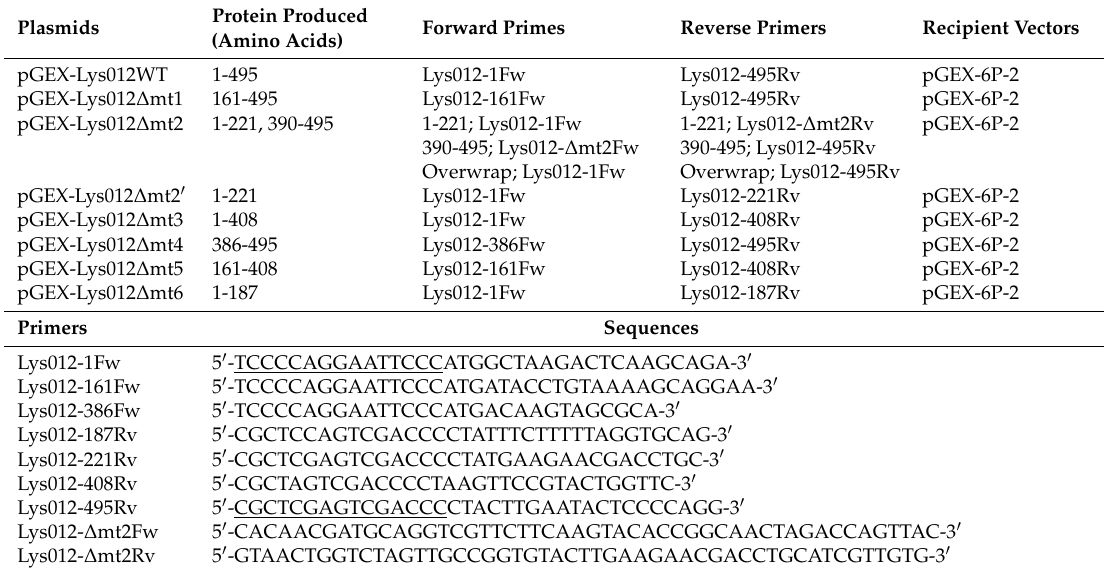
Table 2. Plasmids and